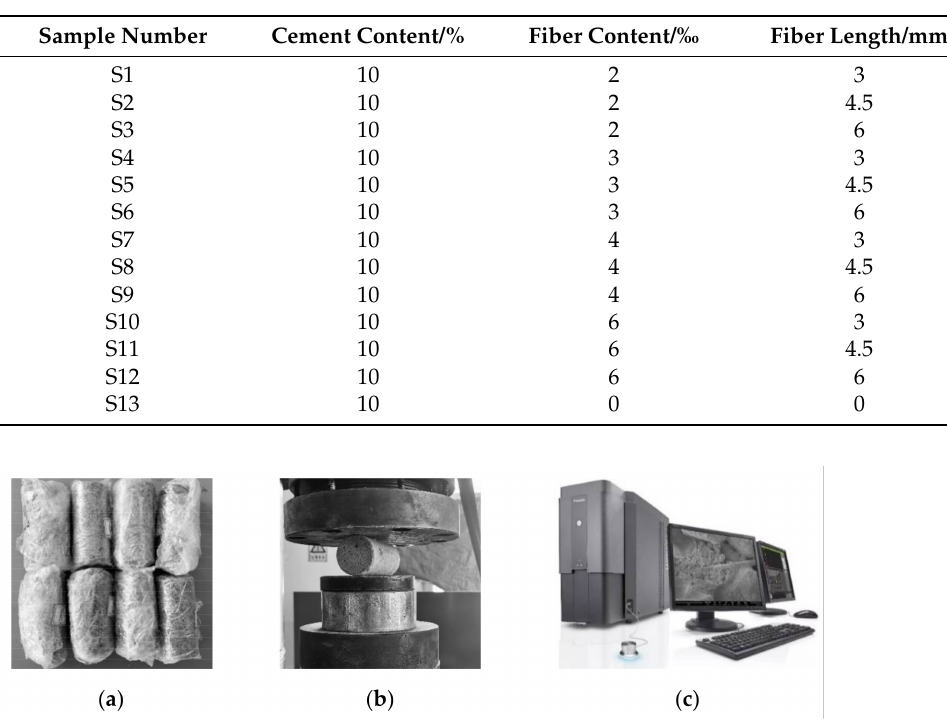
Table 6. Control variable test plan.